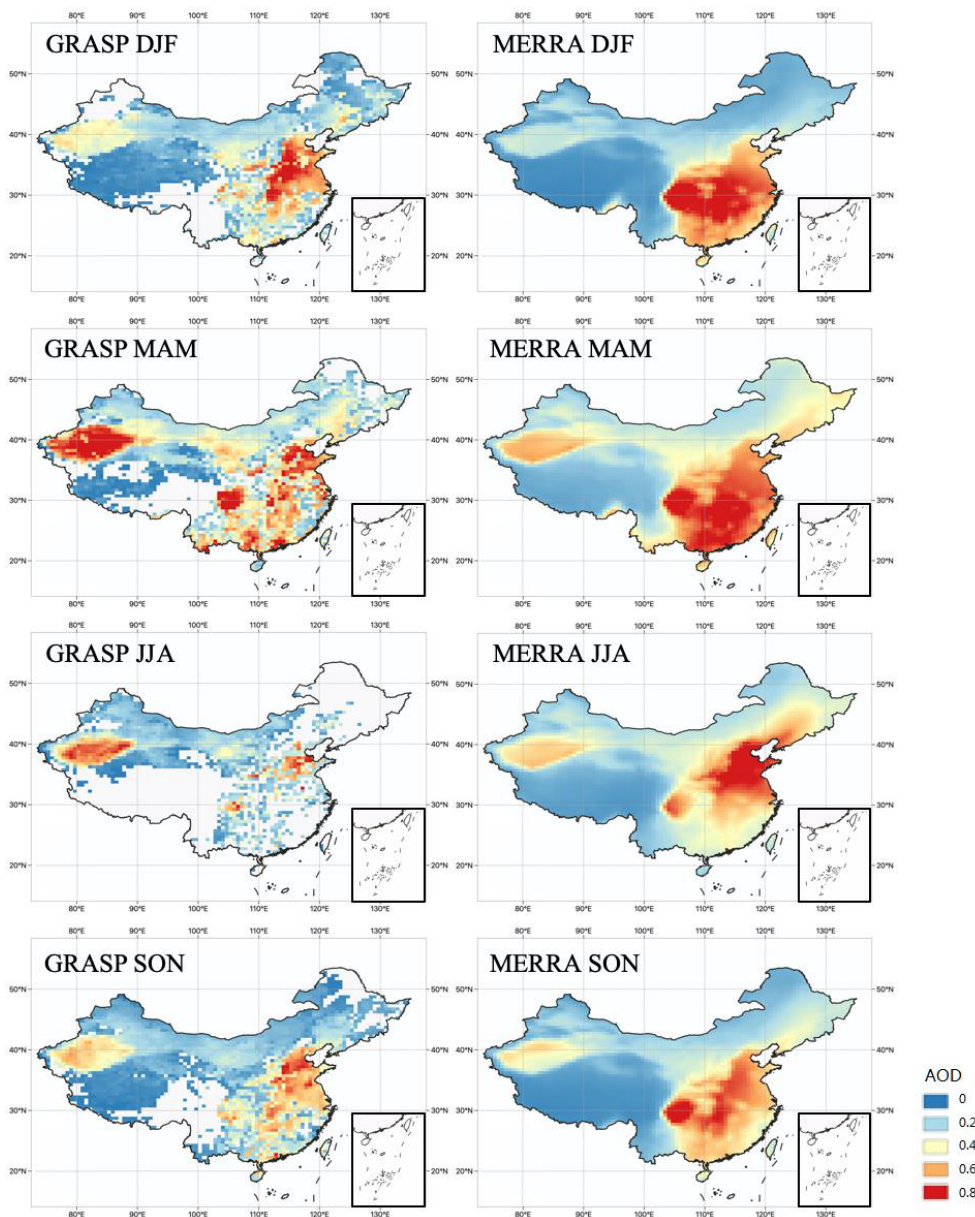
Figure 9. Spatial distribution of 2011–2013 seasonal AOD from MERRA-2 and PARASOL/GRASP over